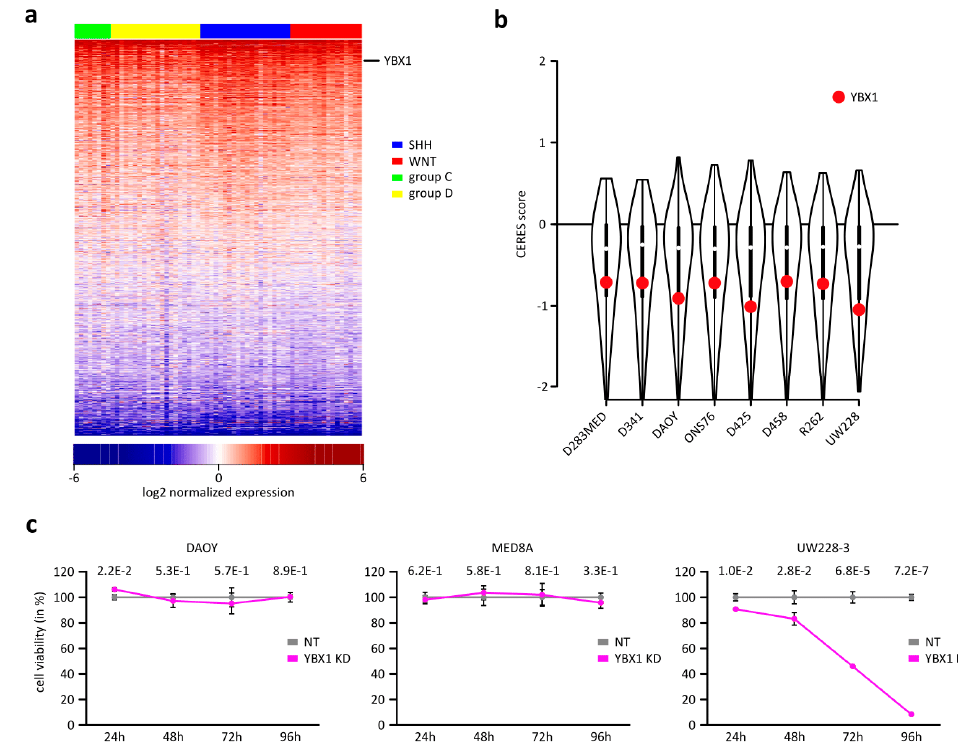
Figure 1. YBX1 is essential for cellular survival in medulloblastoma patients and cell lines. ( a ) Heatmap representation of a set of expression of 1220 RNA-binding proteins across medulloblastoma patients out of a total of 1827 RBPs (the remainder of RBPs was not present on the microarrays). Rows are sorted by average expression across all patients, and log2 normalized expression value is shown. ( b ) CERES score representing the essentiality of genes for survival of 483 RNA-binding proteins as in a), downloaded from DepMap for a total of eight medulloblastoma cell lines. YBX1 CERES score is highlighted. ( c ) Cell viability assay showing survival for three medulloblastoma cell lines upon YBX1 knockdown (KD) measured at di ff erent time points (YBX1 siRNA-mediated knockdown compared to control; each time point was normalized against its respective control sample).